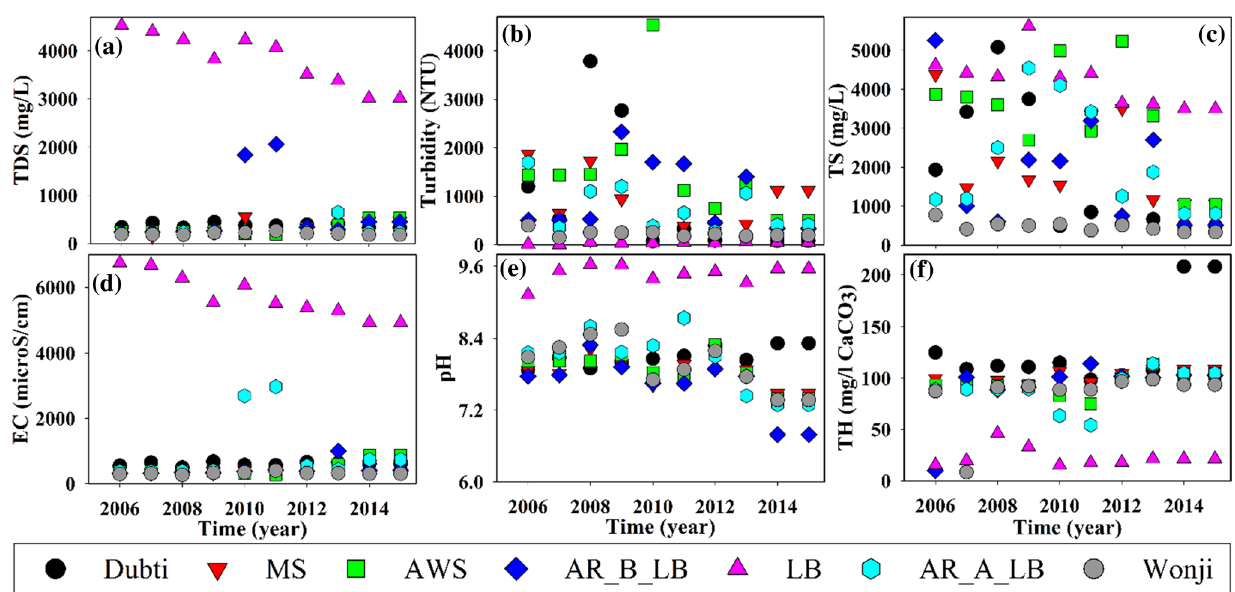
Fig. 4 Spatiotemporal variabilities of the concentrations of physicochemical parameters in the Awash River and the Lake